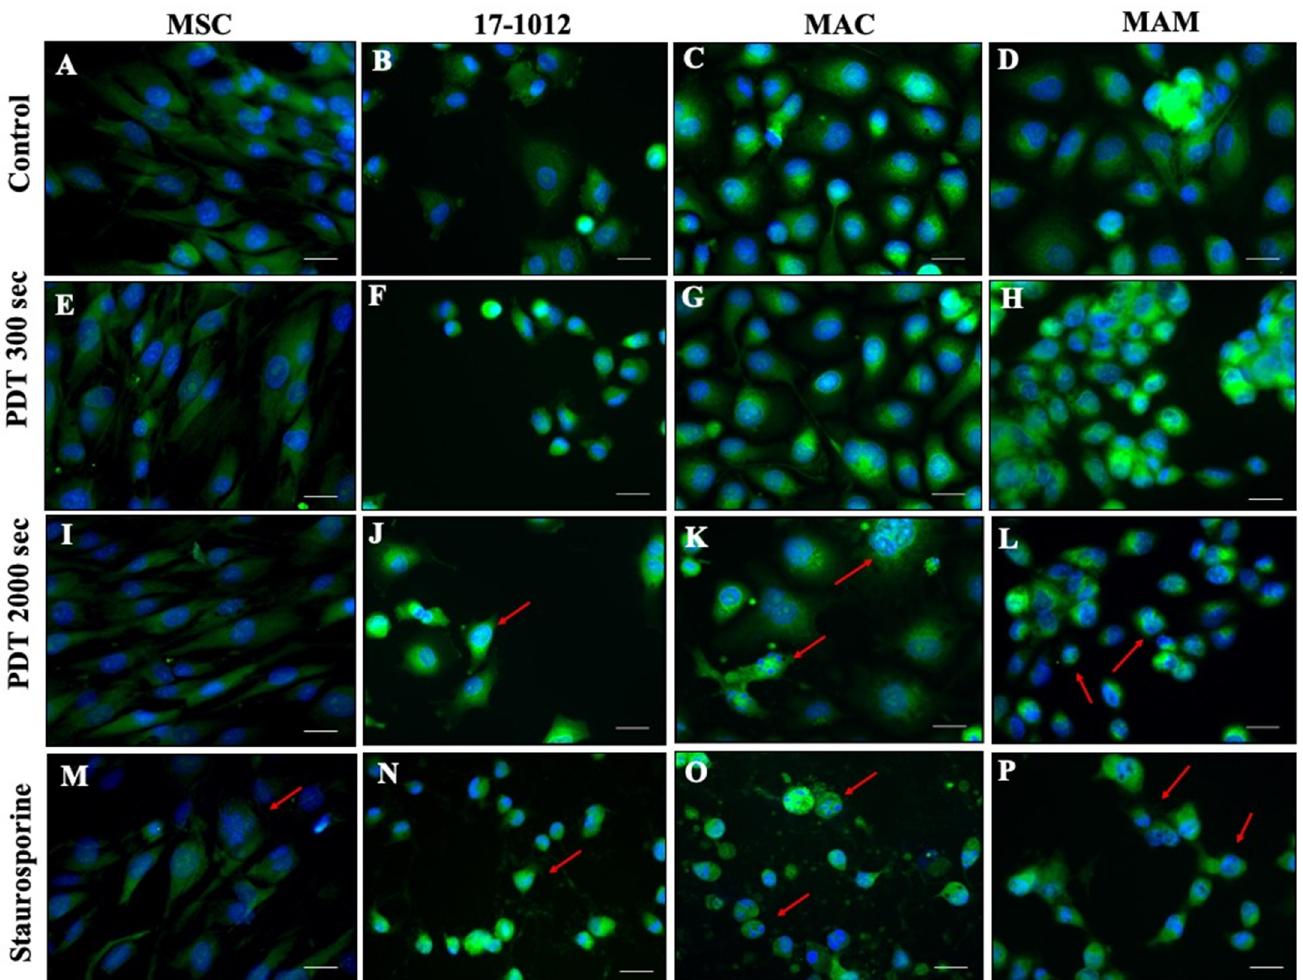
Figure 4. Representative figures of nuclear fragmentation assessment after PDT exposure with 5-ALA as a photosensitizer at a concentration of 1.5 mM . All cell lines (MSC—bone marrow-derived mesenchymal stem cells ( A , E , I ), 17-1012—giant cell tumor of bone ( B , F , J ), MAC—bone metastases of invasive ductal breast carcinoma ( C , G , K ), MAM—bone metastases of renal cell carcinoma ( D , H , L ) were subjected to PDT exposure for predefined time frames of either 300 s or 2000 s). Staurosporine positive controls were included for cell lines (MSC: M, 17-1012: N, MAC: O, MAM: P). 40-fold magnification, scale bar (white) represents 50 μ m. Red arrows pinpoint nuclear fragmentation. Pictures are representative of three independent experiments. Cells not subjected to PDT served as a control. Abbreviations: 5-ALA— 5-aminolaevulinic acid, PDT—photodynamic therapy.